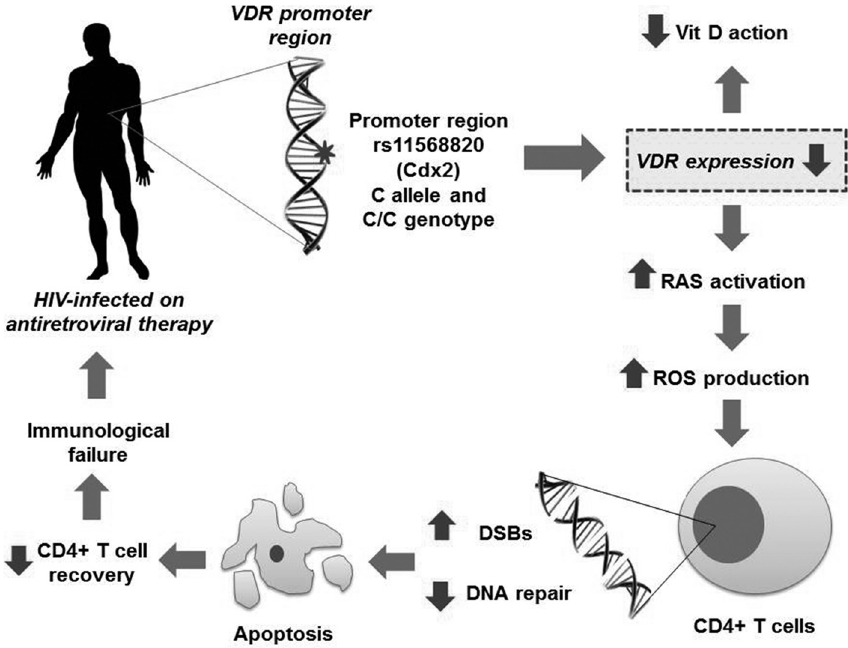
Figure1 -HypotheticalmodeloftheVDRreceptorinvolvementinHIV-infectedindividualstreatedwithantiretroviraltherapyandshowingimmunolog- ical